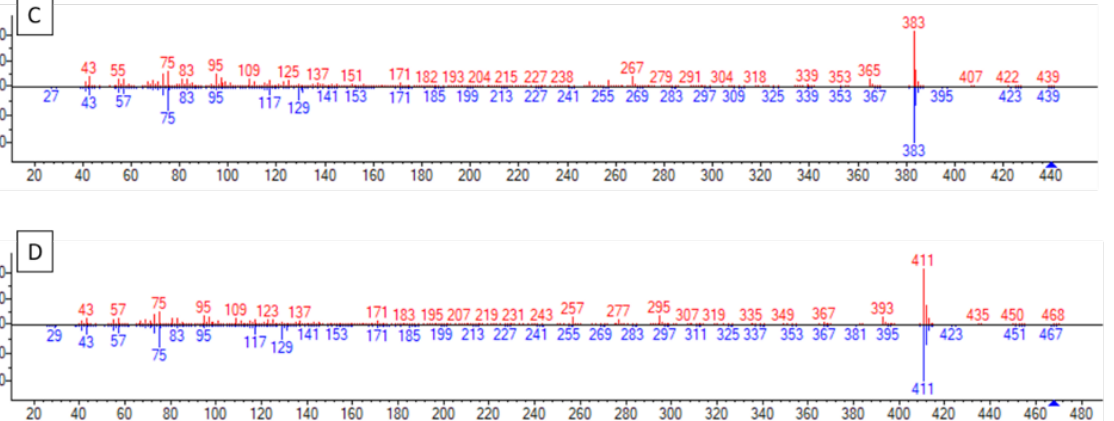
Fig 3 . Expansion of the total ion chromatogram (A) and similarity of the mass spectra of the compounds with the largest relative areas identified in the floral oil of nance ( Byrsonima sericea ), showing the mass spectra from the NIST library in blue. B) Palmitic acid; C) Heneicosanoic acid; D) Ticosanoic